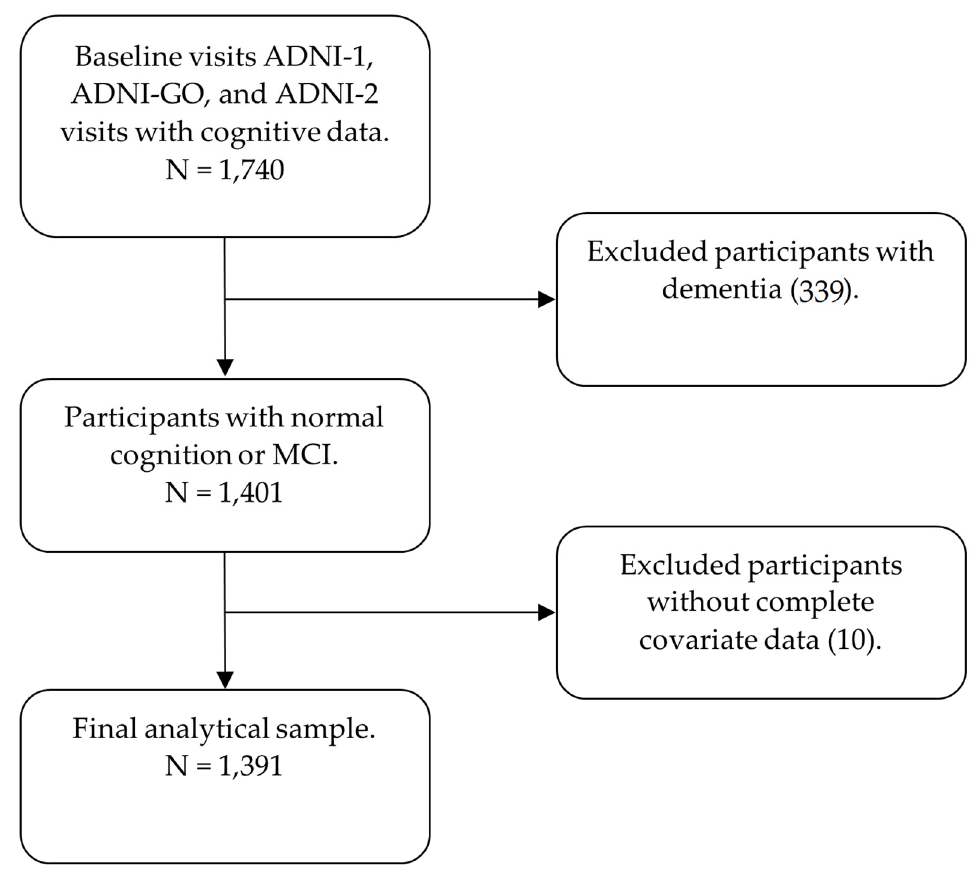
Figure 1. Diagram depicting the analytical Figure 1. D iagram depicting the analytical sample.